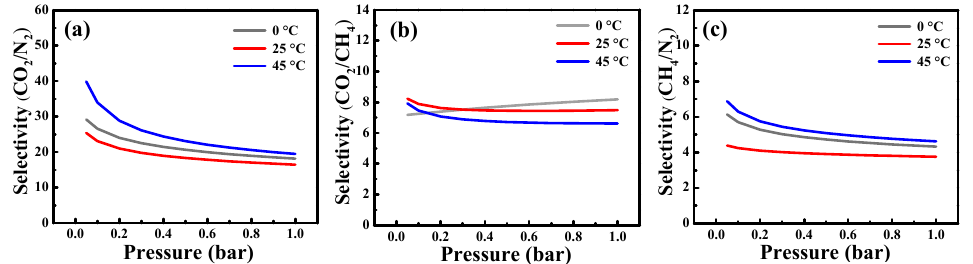
Figure 8. IAST-predicted adsorption selectivities of binary mixtures for ( a ) CO 2 / N 2 (15 / 85), ( b ) CO 2 / CH 4 (10 / 90), and ( c ) CH 4 / N 2 (30 / 70) on ACSs-N. Isosteric heat of adsorption (Qst) is an important thermodynamic parameter to evaluate the interaction between adsorbate gas molecules and an adsorbent [5,6,38], which can be estimated from the adsorption isotherms at different temperatures by using the Clausius − Clapeyron equation.